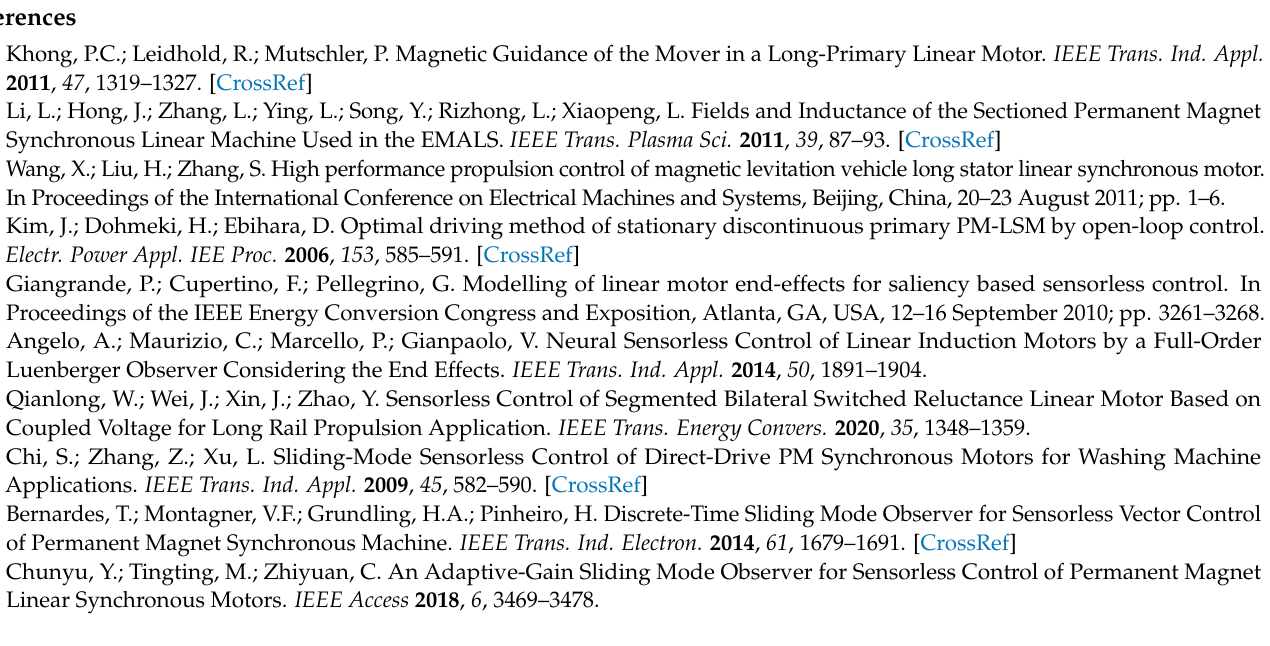
Figure 16. The experiment under load conditions. ( a ) Position; ( b ) speed.